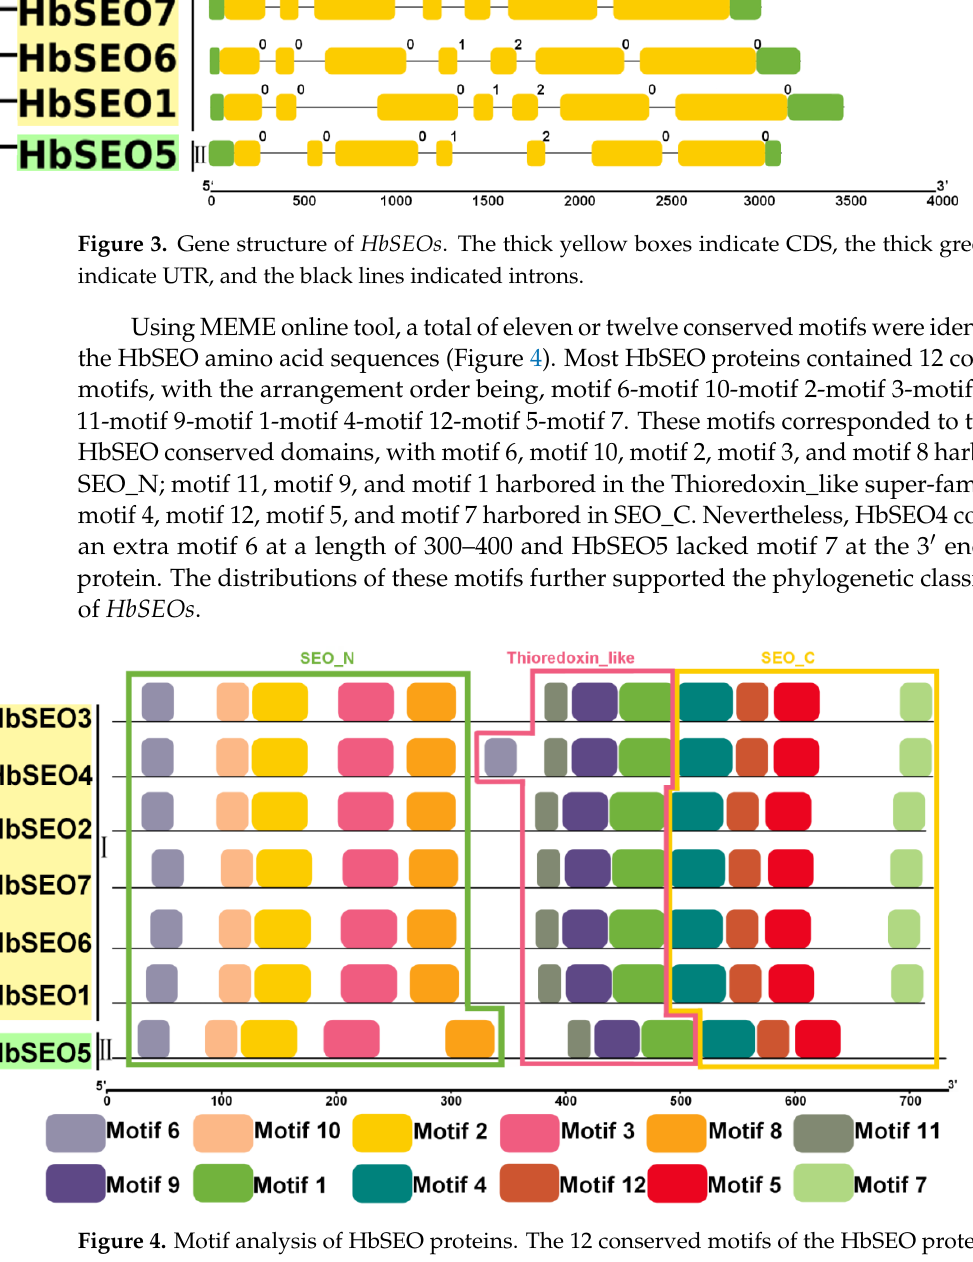
Figure 4. Motif analysis of HbSEO proteins. The 12 conserved motifs of the HbSEO proteins were detected using the online MEME program and drawn using TBtools. The length of protein can be estimated using the scale at the bottom.